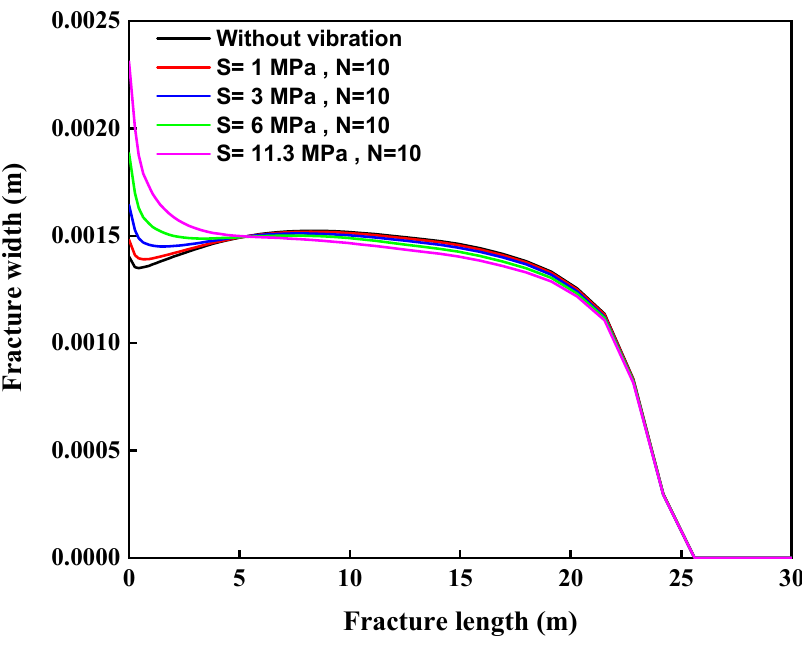
Figure 8. Fracture width versus fracture length for different cyclic load magnitude and constant number of cyclic loads at the final stage of simulation ( t = 100 s).